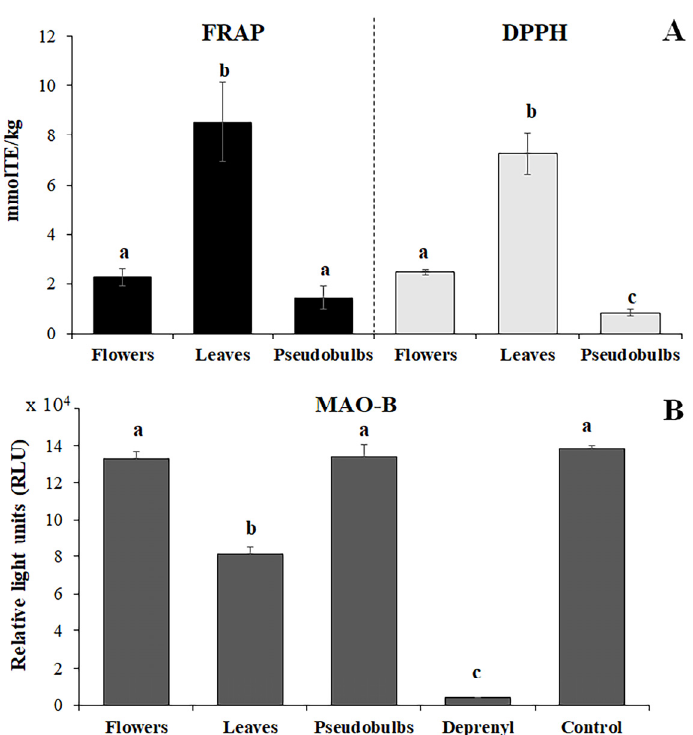
Figure 6. Antioxidant and MAO-B inhibition assays of flower, leaf and pseudobulb extracts. ( A ) Antioxidant (FRAP, DPPH) assays, with values expressed as Trolox equivalents. ( B ) MAO-B assay using undiluted samples, with values expressed as relative light units (RLUs). In this assay, 2.5 µM deprenyl was used as a positive control, and MAO buffer without inhibitor as a negative control. Data are means ± standard deviation ( n = 3, one-way ANOVA with Tukey’s post hoc test, and different lowercase letters represent statistically significant differences between groups, p < 0.05).